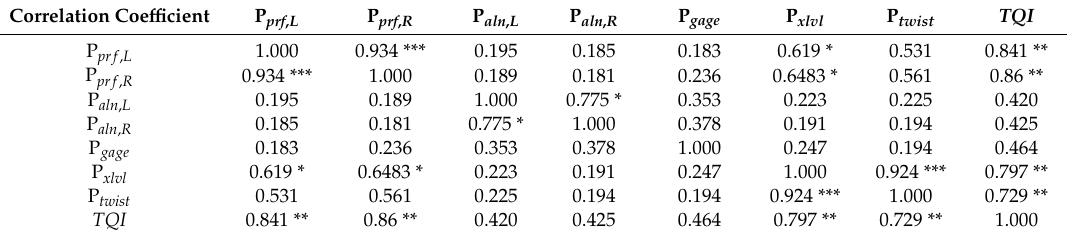
Table 5. The correlation coe ffi cient between geometric parameters (unit: mm).